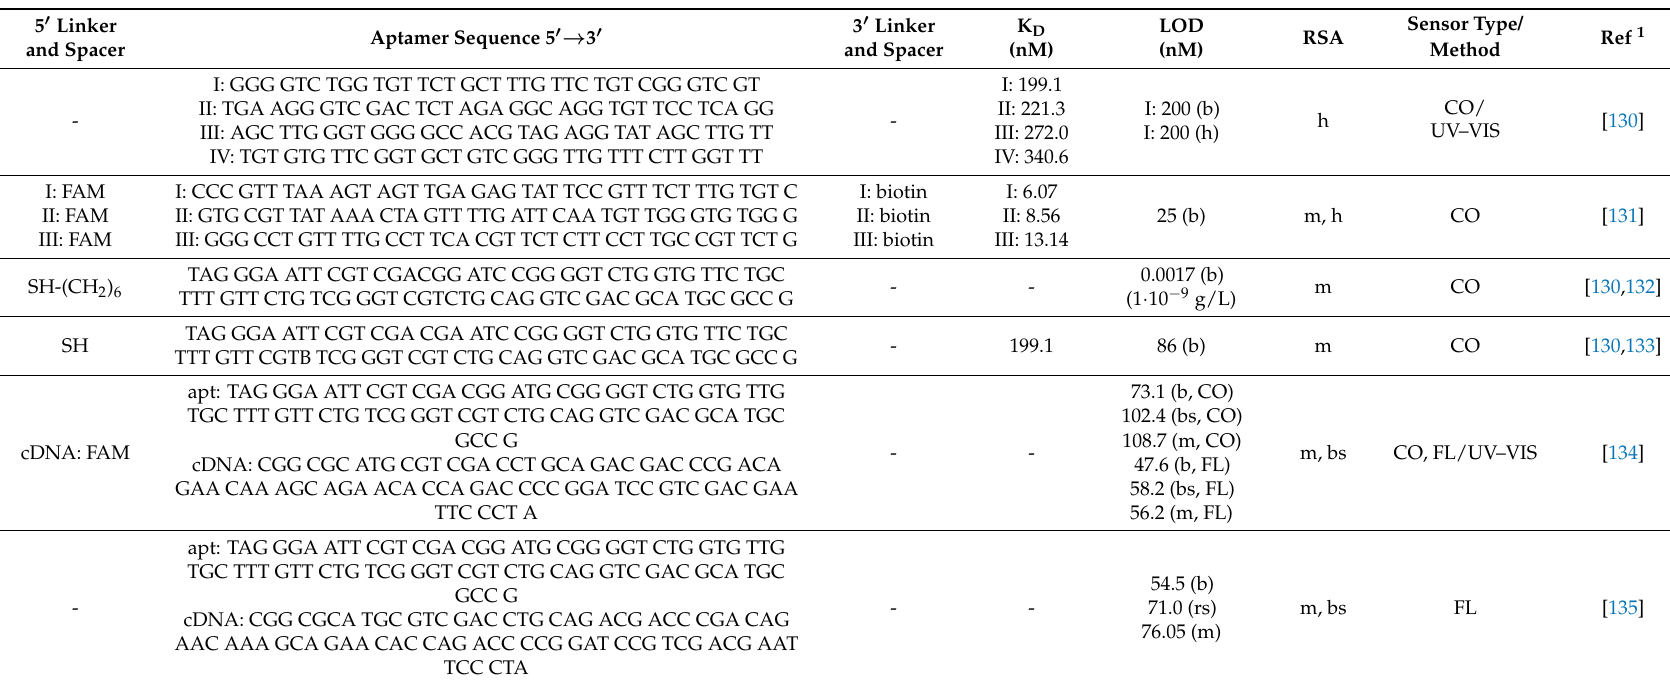
Table 7. Aptamer sequence, dissociation constant (K D ), limit of detection (LOD), real sample analysis (RSA), and realized sensor type and measuring method for streptomycin, mentioned in the corresponding references (Ref). AEC = amperometric electrochemical, b = buffer, bs = blood serum, cap = capture probe, cDNA = complementary DNA, CO = colorimetric, DPV = differential pulse voltammetry, FAM = fluorescein amidite, FL = fluorometric, h = honey, IEC = impedimetric electrochemical, m = milk, PEC = photoelectrochemical, rs = rat serum, and SWV = square wave